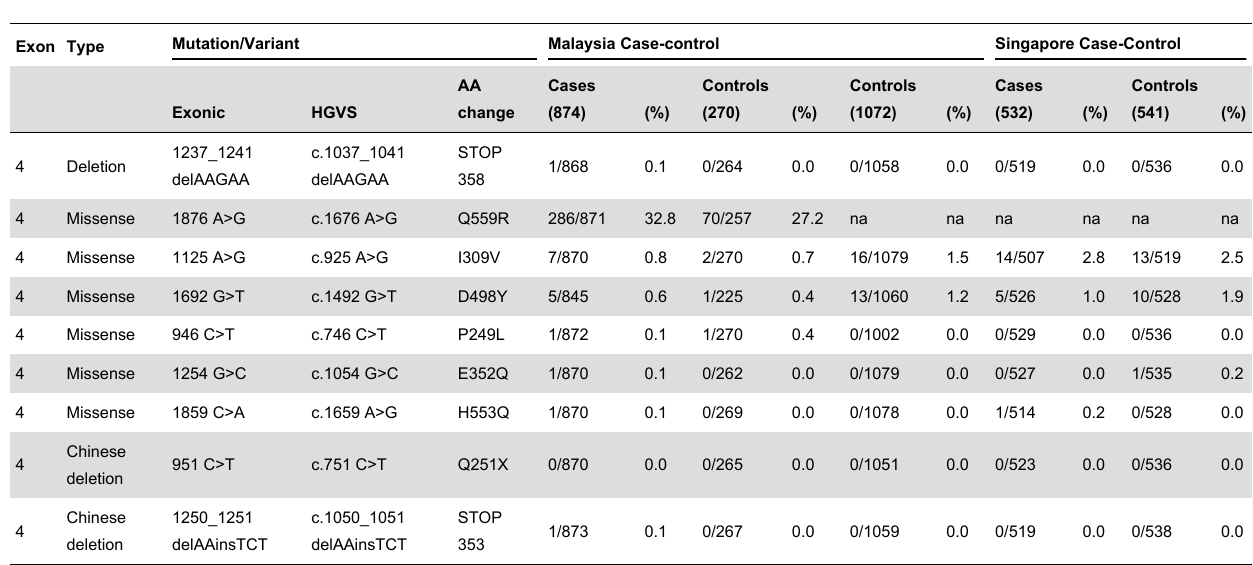
Table 3. Case-control analysis of nine PALB2 variants identified from exon 4 sequencing (n=7) and Asian populations